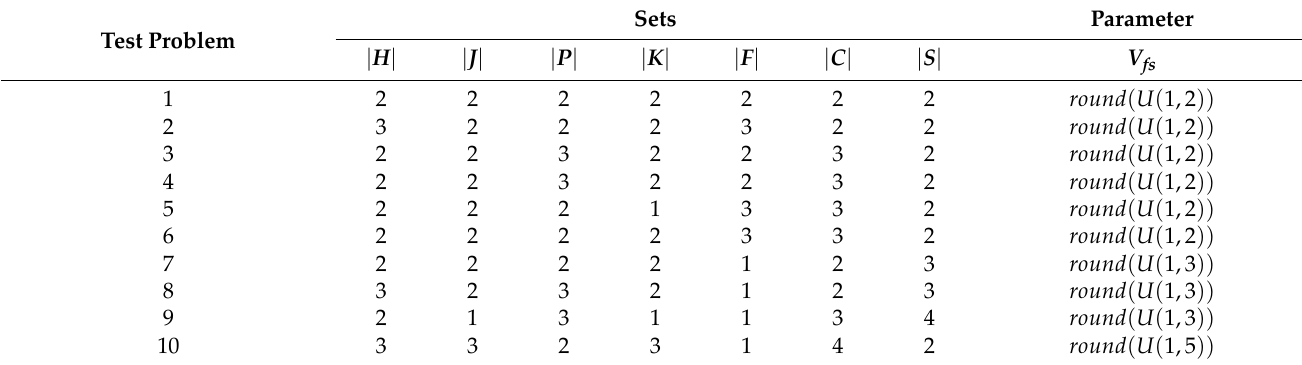
Table 3. Designed instances.